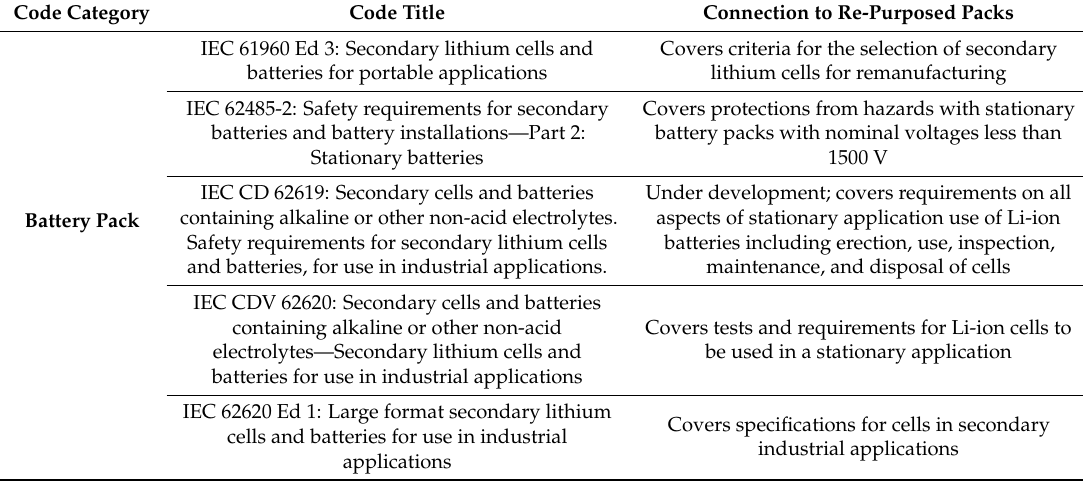
Table 2. Applicable codes for re-purposed Li-ion battery packs in a stationary application and the re-purposed battery pack assembly.